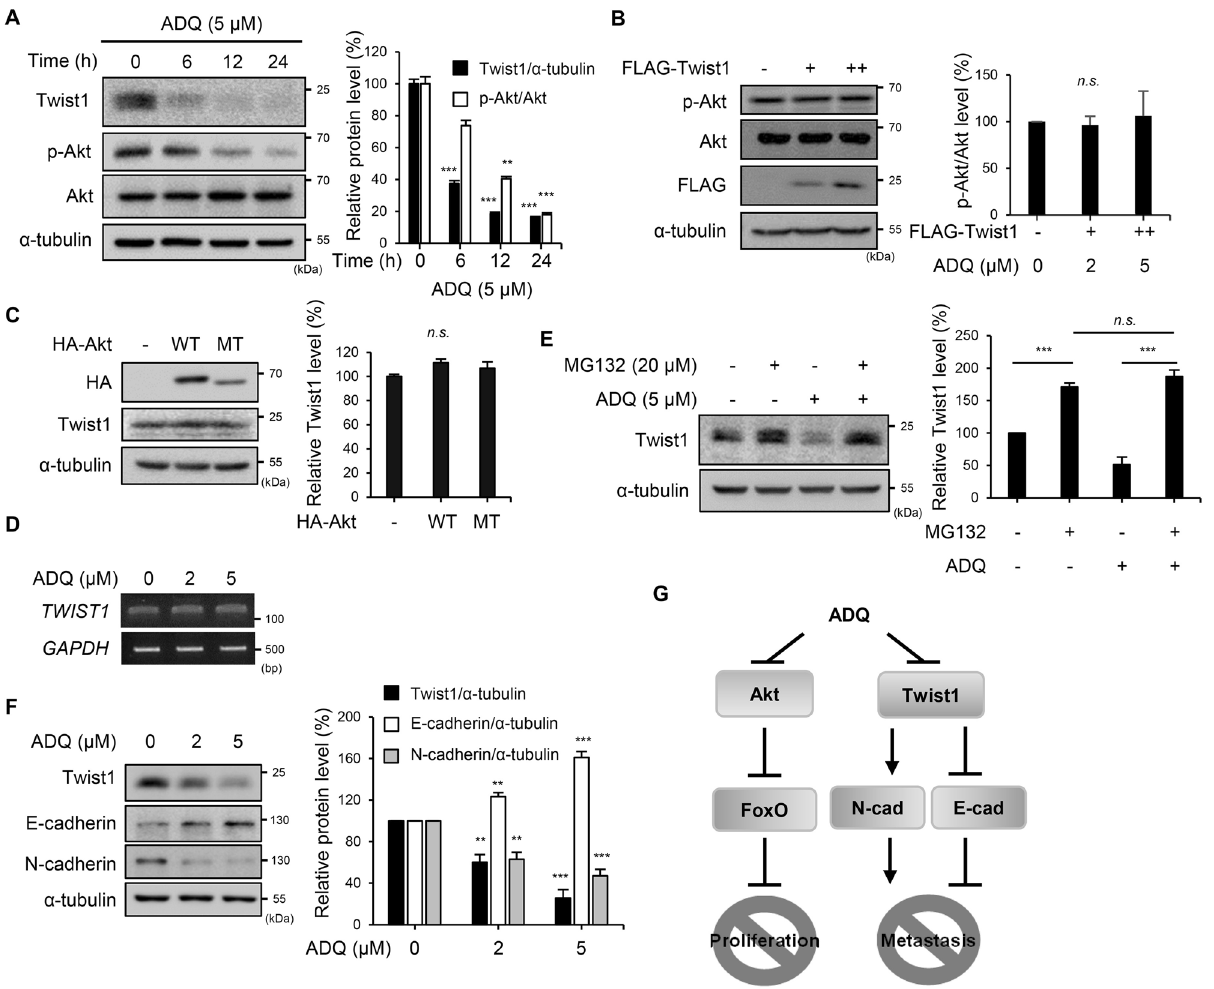
Figure 4. The stability of the Twist1 transcription factor was decreased by ADQ. ( A ) SK-Hep1 cells were treated with 5 μM ADQ in 10% FBS-containing media and were harvested at the indicated time points. The expression levels of Twist1, p-Akt (Ser473), Akt, and α-tubulin were detected by specific antibodies. ( B ) FLAG-Twist1 (0, 2, or 4 μg) was transfected into SK-Hep1 cells. After 48 h, total cell lysates were harvested and separated by SDS- PAGE. The expression levels of FLAG, p-Akt (Ser473), Akt, and α-tubulin were detected by specific antibodies. ( C ) SK-Hep1 cells were transfected for 48 h with HA-AKT WT or MT K179M. The lysates were separated by SDS-PAGE, and the expression levels of HA, Twist1, and α-tubulin were detected by specific antibodies. WT, wild type; MT, mutant type. ( D ) RNA was harvested from the cells treated with ADQ for 24 h in 10% FBS media. The transcription levels of TWIST1 and GAPDH were evaluated by RT-PCR. ( E ) Cells were treated either with ADQ (5 μM) or MG132 (20 μM) for 6 h in 10% FBS media. The expression levels of Twist1 and α-tubulin in the cell lysates were analyzed by specific antibodies. ( F ) After 24 h of incubation with ADQ in 10% FBS media, total cell lysates were harvested and analyzed by immunoblotting. The expression levels of Twist1, E-cadherin, N-cadherin, and α-tubulin were observed by specific antibodies. ( G ) Schematic representation of ADQ inhibiting the Akt pathway and Twist1. Data are representative of three experiments and expressed as the means ± SEM. Data were analyzed by one-way ANOVA followed by Holm-Šídák’s post hoc test; *p < 0.05, **p < 0.01, and ***p < 0.001 relative to the ADQ-untreated